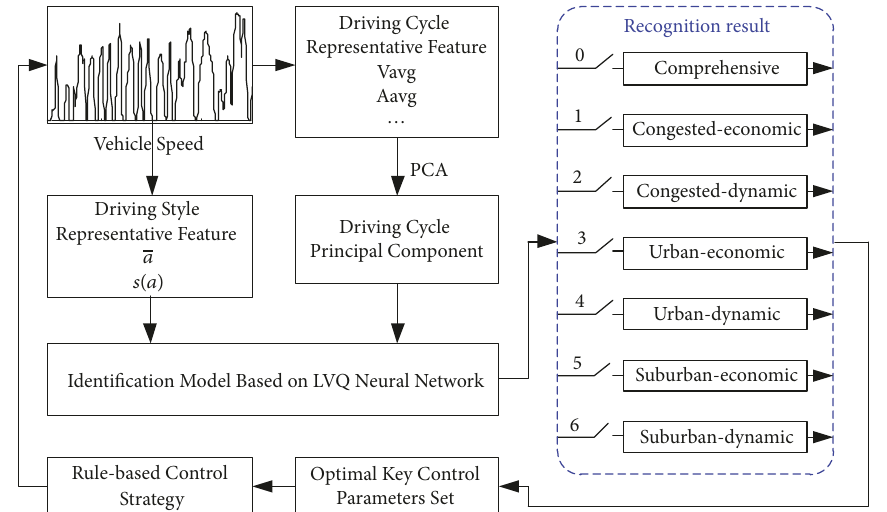
Figure 7: Control strategy based on dual identification.